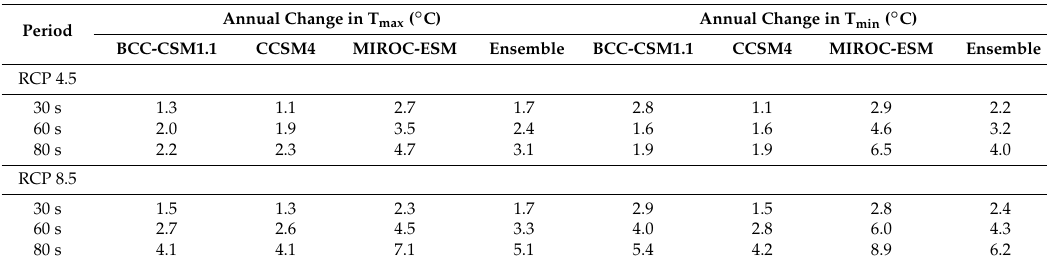
Table 7. Variations in annual T max and T min under RCP 4.5, and RCP 8.5 scenarios during the three future periods, relative to the baseline period